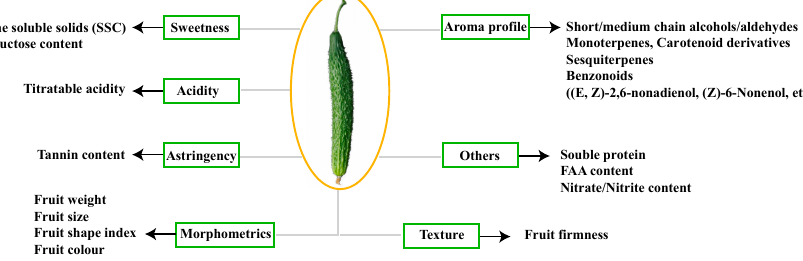
Figure 1. Overview of the major factors determining the quality of cucumber fruit. FAA—free amino acid.